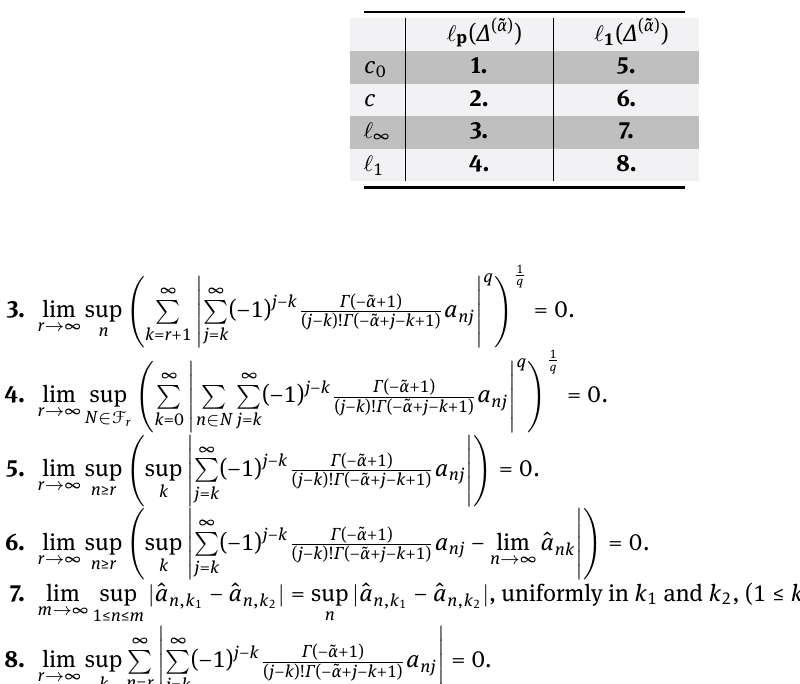
Table 1: Necessary and suflcient conditions for an operator to be compact for 1 < p <